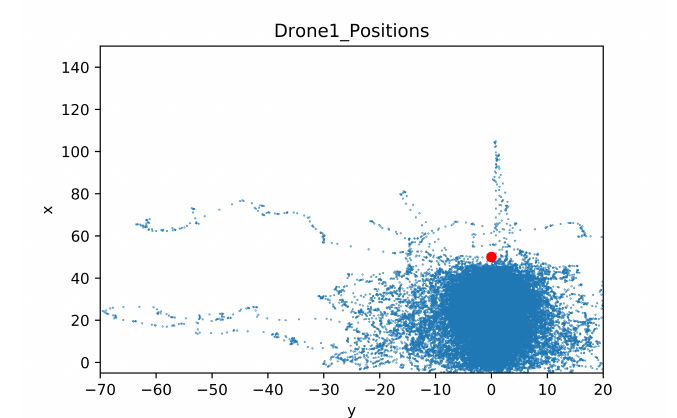
Figure 25. Drone Position Map for Baseline.